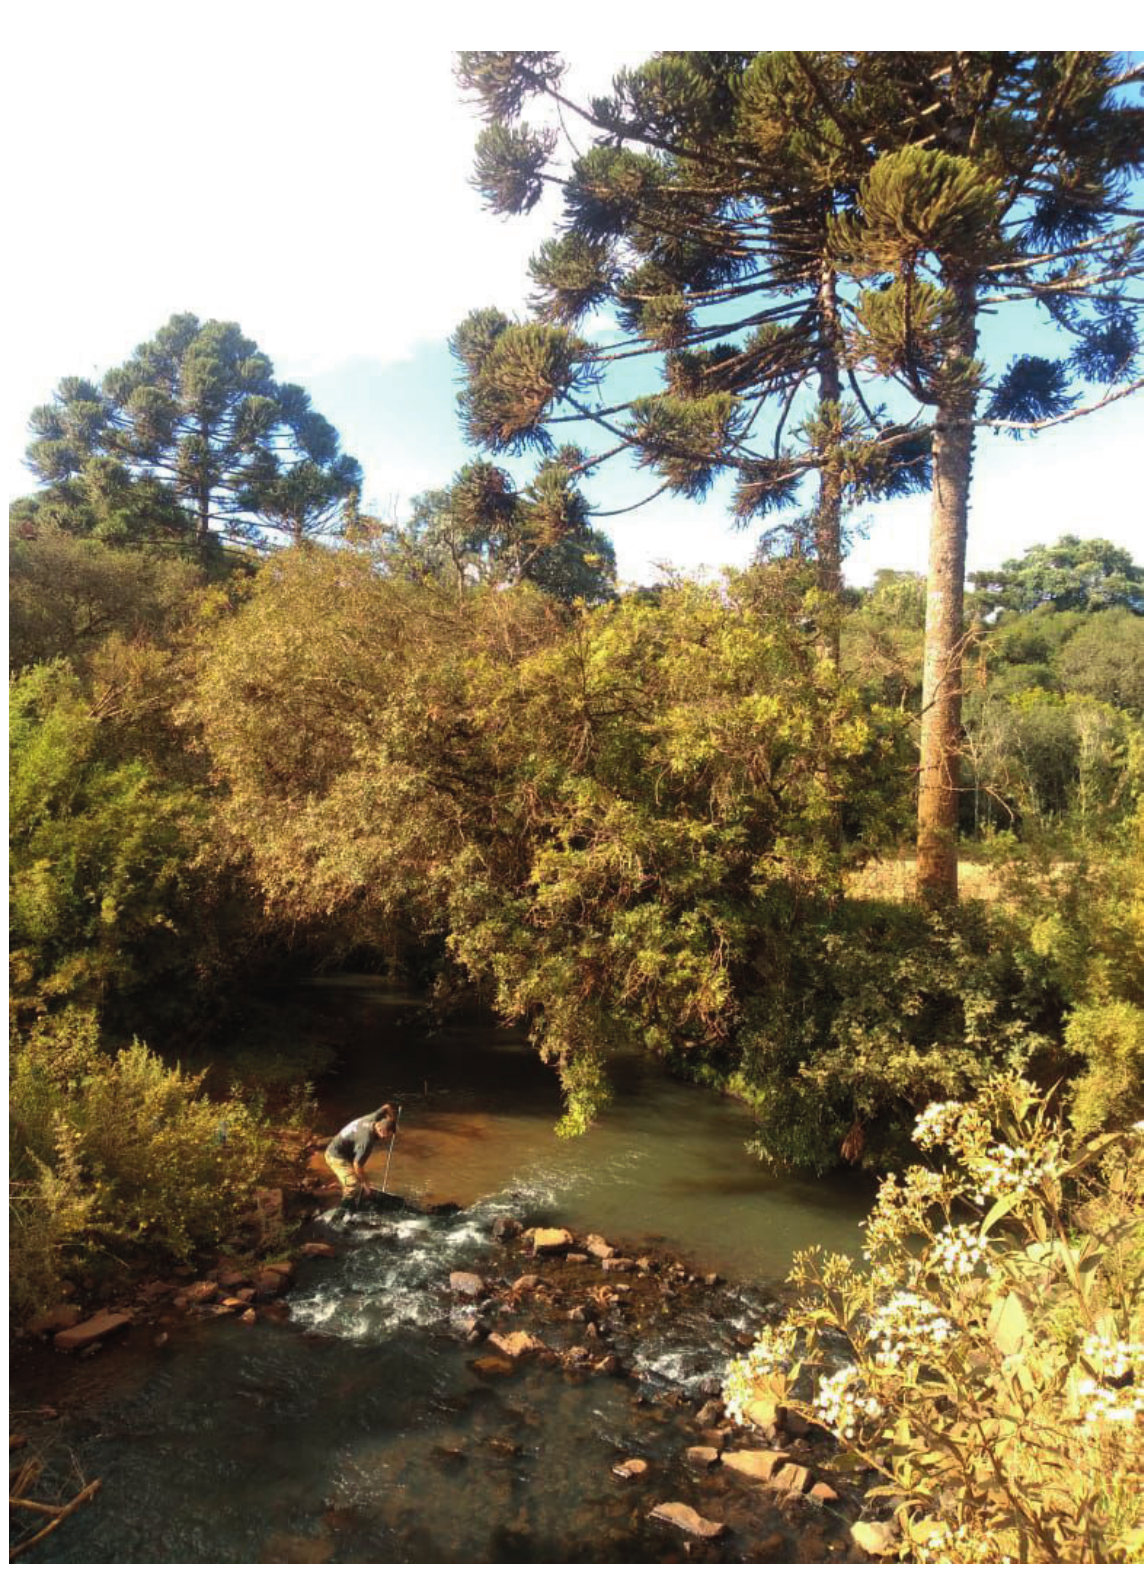
Fig. 6. Type locality of Cambeva betabelardense sp.